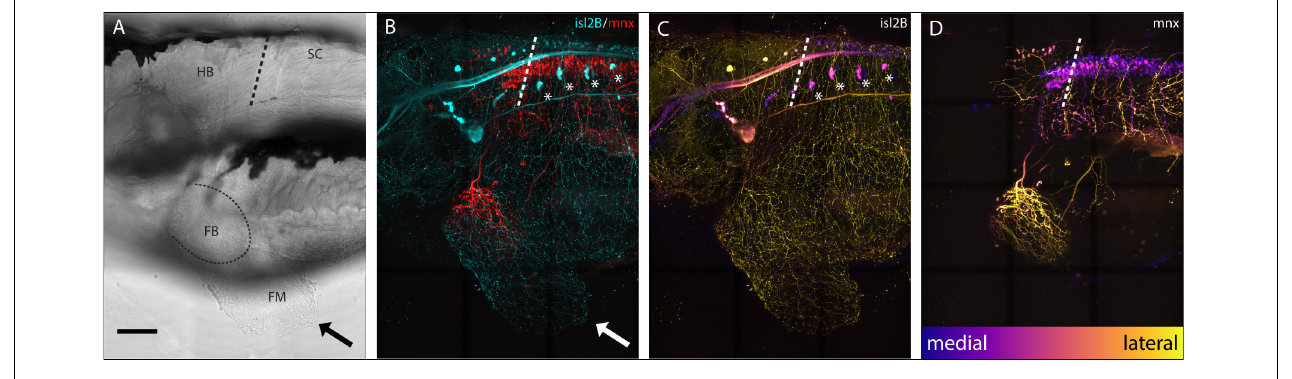
FIGURE 1 | islet2B + neurons innervate the pectoral fins of 5 dpf larval zebrafish. (A) Brightfield lateral view of a 5 dpf larval zebrafish. Arrow indicates distal fin membrane, and dotted line indicates the blood vessel boundary between the fin body (FB) and fin membrane (FM). (B) Tg[islet2B:GFP] × Tg[mnx1:Gal4;UAS:pTagRFP] double transgenic fish ( N = 4) showing sensory neurons and their processes (cyan) and motor neurons and their processes (red). Arrow indicates distal fin membrane. Asterisks indicate DRGs. (C) Depth coded z-projection of islet2B (neurons highlights the lateral placement of the sensory neuron cell bodies compared to the more medially located mnx1+ motor neurons in (D) . Asterisks indicated DRGs. Depth scale is the same for (C,D) . Anterior is to the left, dorsal is up in all images. Scale is 100 microns.